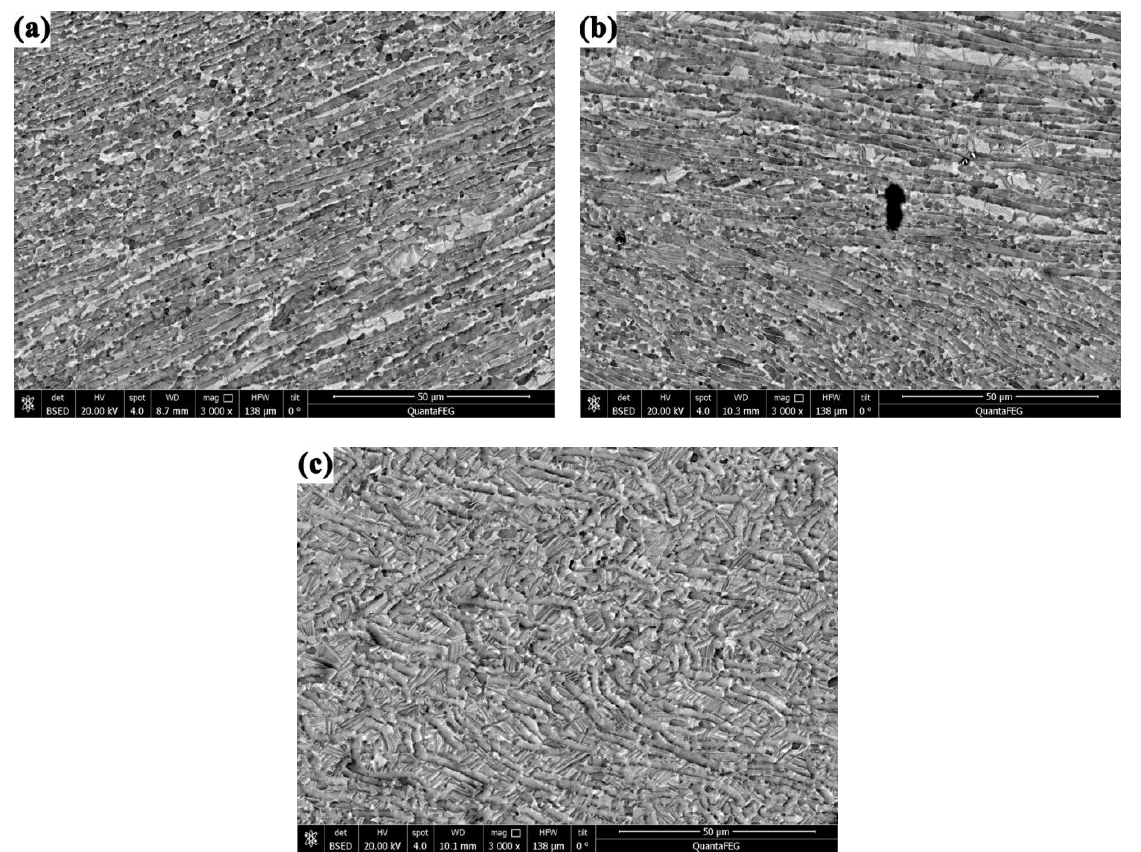
Figure 7. Microstructures of Ti-6Al-4V specimens deformed at ( a ) 900 °C/5 × 10 −2 s −1 , ( b ) 900 °C/10 −1 s −1 , and ( c ) 950 °C/10 −1 s −1 .